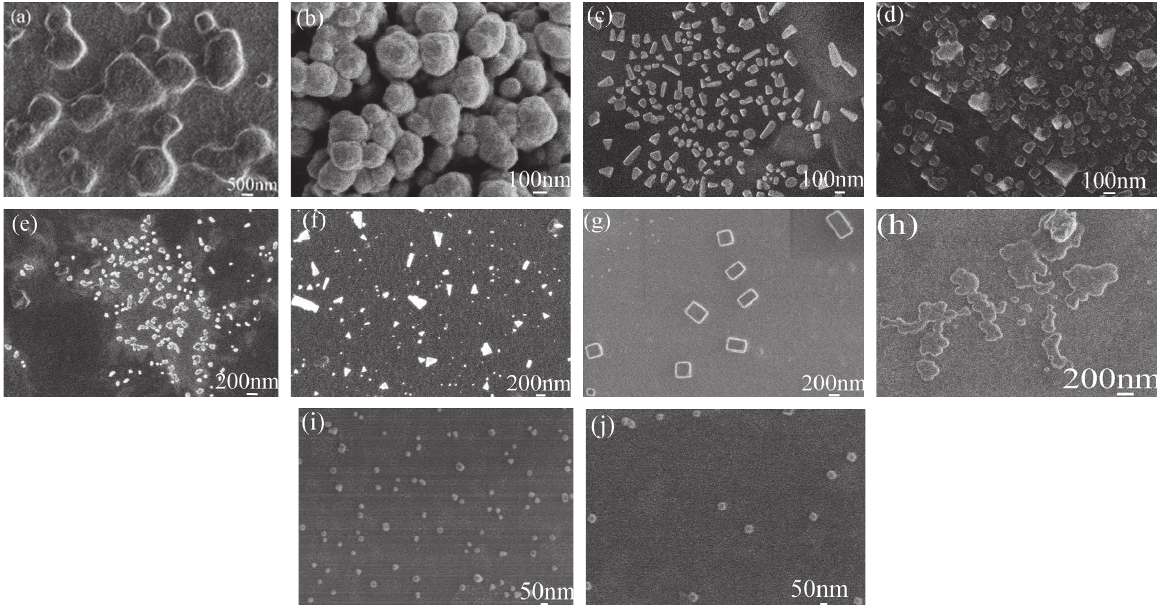
Figure 2: SEM images of SA/chitosan micro/nanoparticles loaded with CS prepared by different process parameters. (a)–(d) The voltage of 16kV, the stirring rate of 800rpm, and the weight ratio of SA to CS of 5 :1 at flow rate of (a) 0.3mL/h; (b) 0.6 mL/h; (c) 1.0 mL/h; (d) 1.2mL/ h. (e, f) The voltage of 16 kV, flow rate of 0.6mL/h, and the weight ratio of SA to CS of 5 :1, with a stirring rate of (e) 600rpm and (f) 1000rpm. (g, h) The stirring rate of 800rpm, flow rate of 0.6 mL/h, and the weight ratio of SA to CS of 5:1, with applied voltages of (g) 13kV and (h) 18 kV. (i, j) The stirring rate of 800rpm, flow rate of 0.6 mL/h, applied voltages of 16kV, and the weight ratio of SA to CS of (i) 2:1; (j)